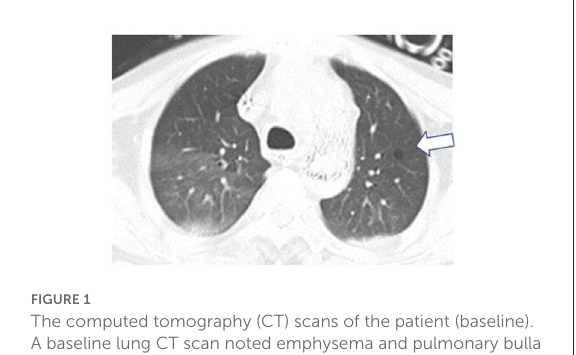
FIGURE1 The computed tomography (CT) scans of the patient (baseline). A baseline lung CT scan noted emphysema and pulmonary bulla in the left lung. The arrow in this figure points to the pulmonary bulla of